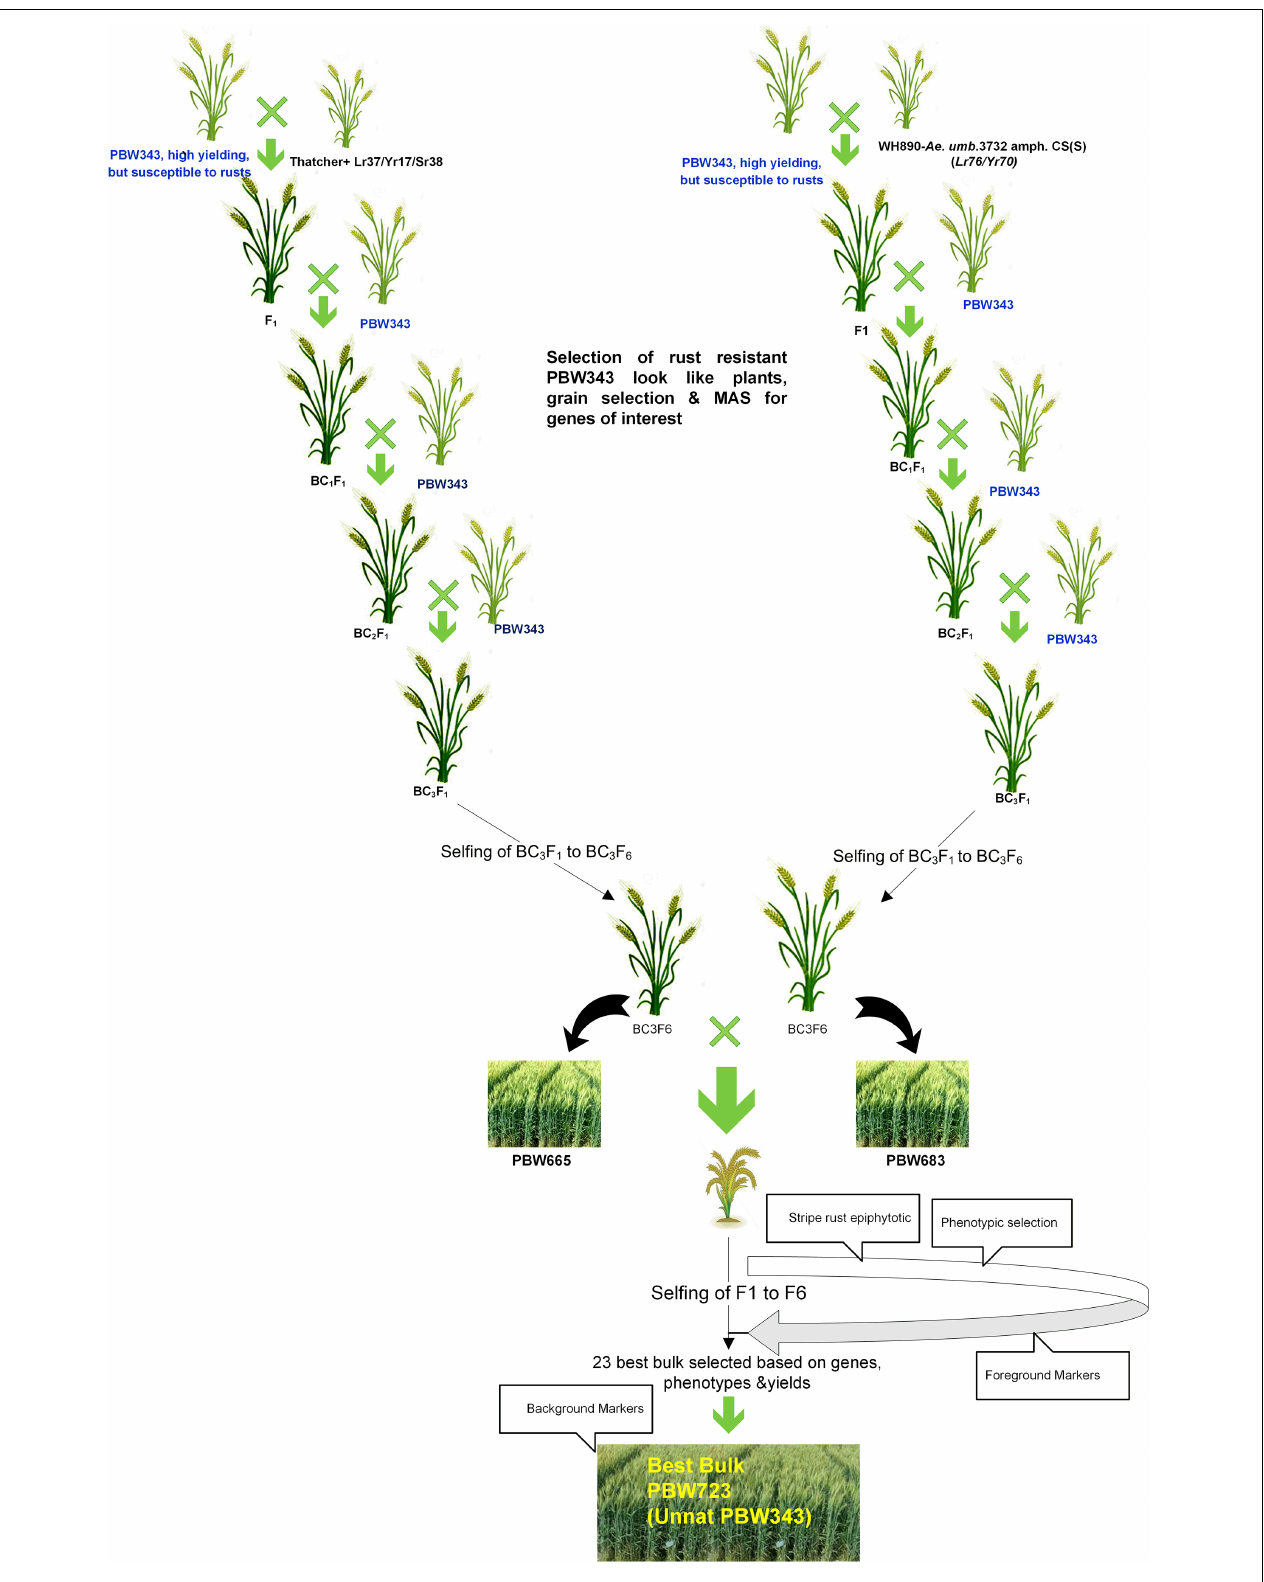
FIGURE 2 | Schematic representation of the development of PBW723 alias Unnat PBW343.